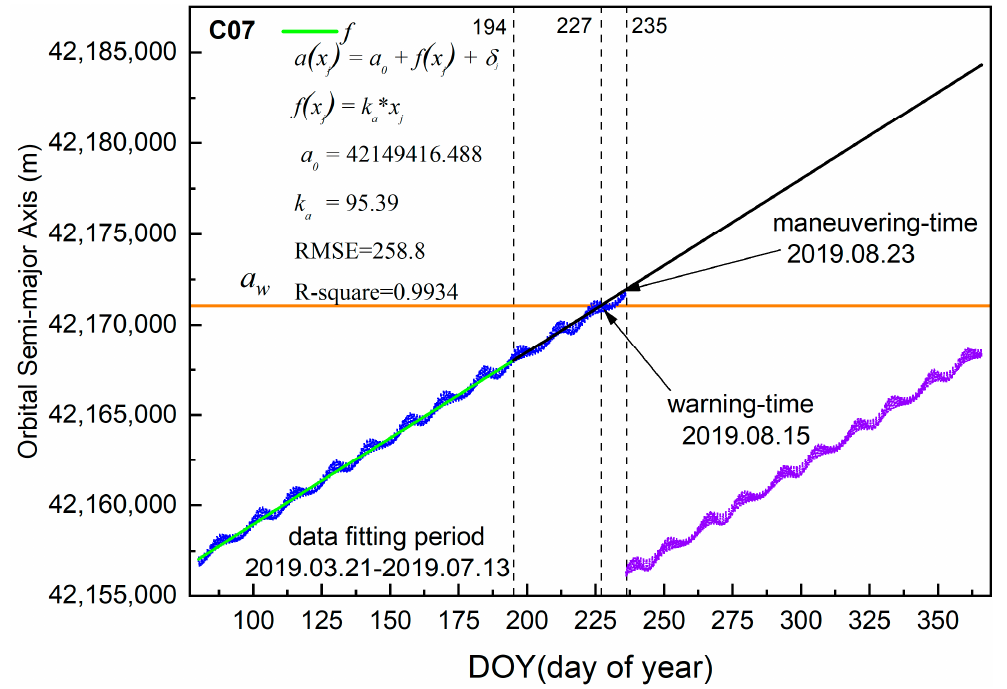
Figure 5. Analysis results of orbital semimajor axis for C07 satellite.